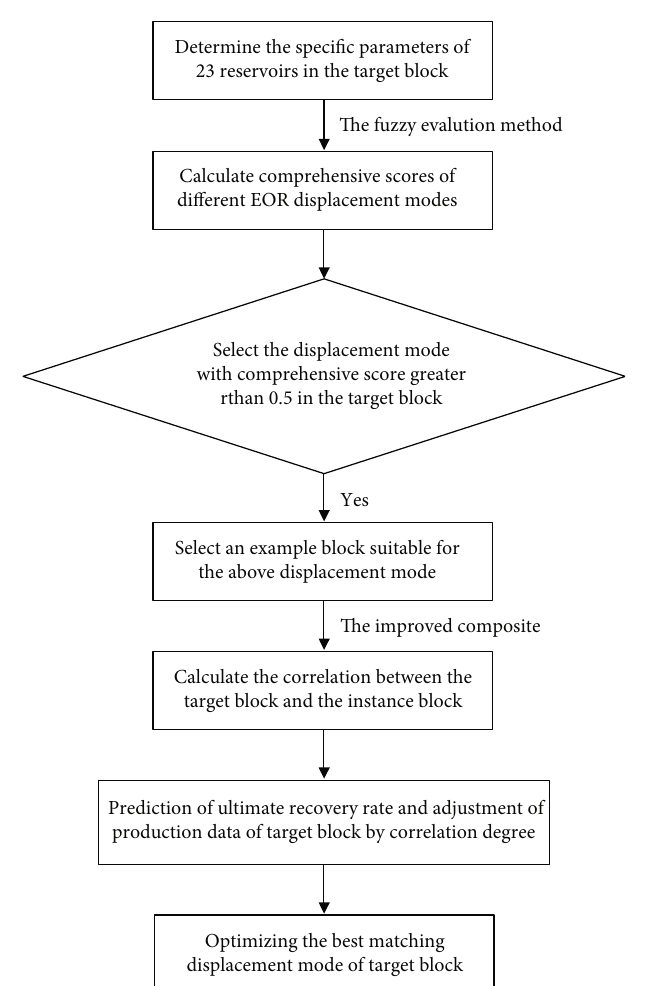
Figure 1: The fl ow chart of optimization method for displacement mode of tertiary oil recovery to enhance oil